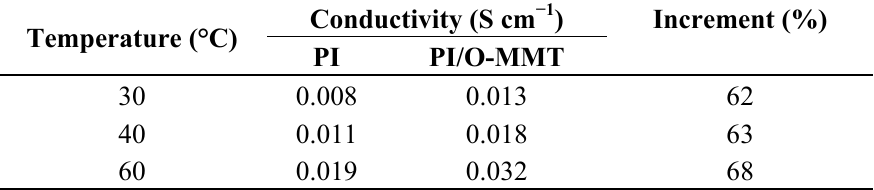
Table 2. Values of conductivities at the investigated